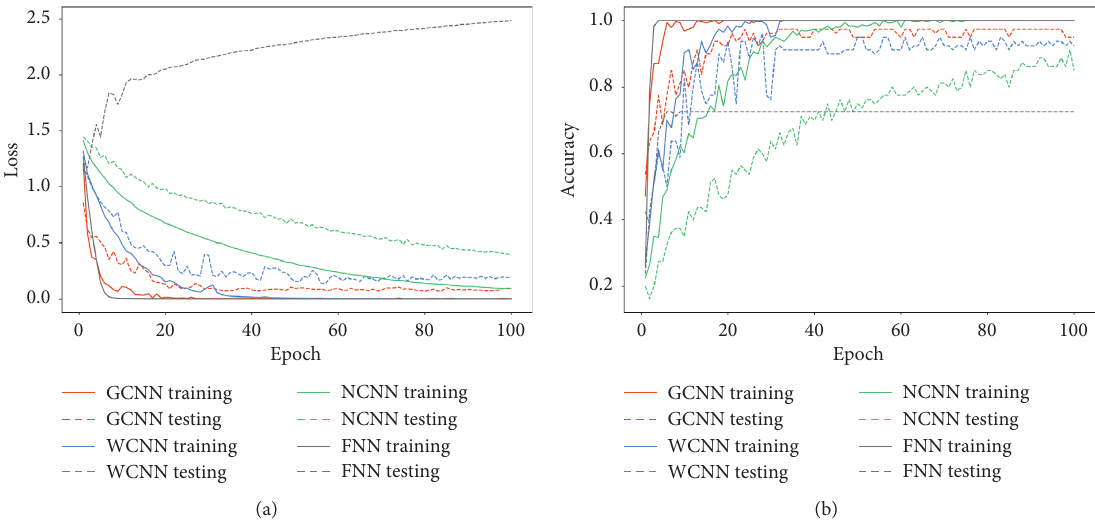
Figure 8: Loss and accuracy curves of the models in experiment 1 with four classes. (a) Loss. (b) Accuracy.